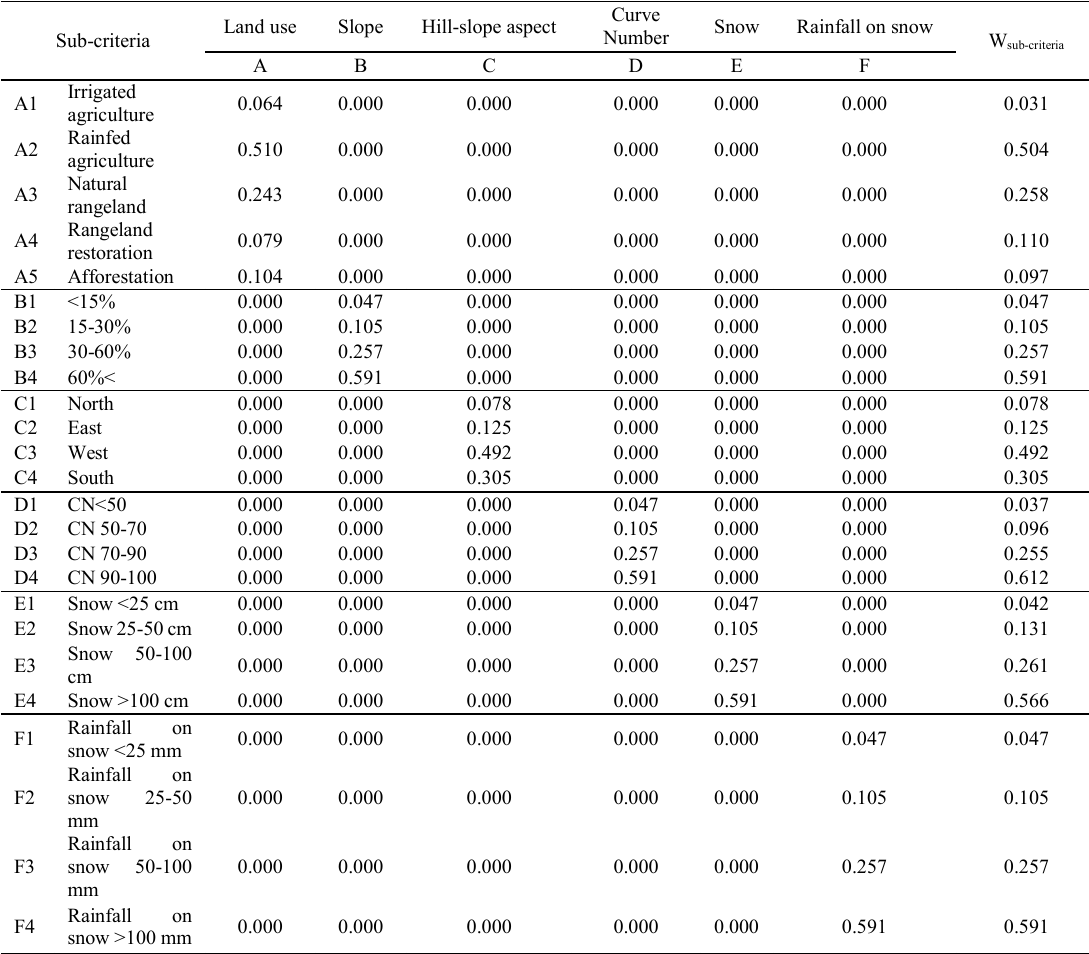
) and the relative importance of the sub-criteria (W 32